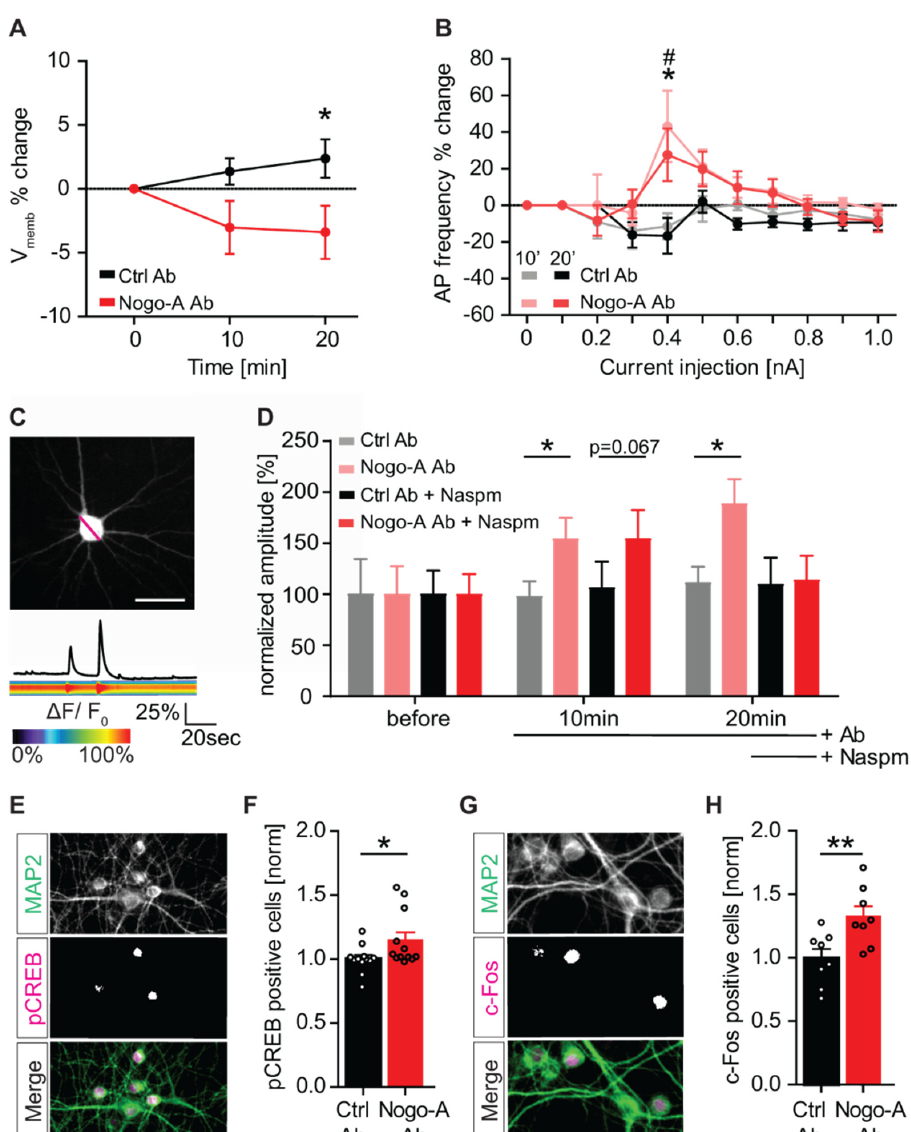
Figure 5. Nogo-A loss-of-function increases neuronal excitability and neuronal activation. ( A , B ) Patch-Clamp electrophysiology recordings of action potential (AP) threshold and frequency upon treatment with either control (black) or Nogo-A function-blocking antibody (red). ( A ) The normalized data show the percentage change of the action potential threshold (V memb ) between both antibody conditions ( n = 11) up to 30 min of treatment. ( B ) The frequency of APs was determined by applying current injections in 0.1 nA steps after 10 min control (grey) and Nogo-A (light red) antibody application, as well as after 20 min (Ctrl-Ab: black, n = 11; Nogo-A Ab: red, n = 10) 10 min: * p , 20min: # p . ( C , D ) Measurement of normalized Ca 2+ transient amplitude percent change in primary hippocampal neurons transfected with GCaMP5g treated either with Nogo-A (red) or control (black) antibody. Antibody treatments were performed for a total time of 40 ( C ) or 20 min with an additional wash in of the CP-AMPAR blocker Naspm after 10 min ( D ). ( E , G ) Immunocytochemical staining for MAP2 (green) and pCREB ( E ) or c-Fos ( G ) (magenta) and their merged image (bottom). For illustration, all images underwent deconvolution and were increased in brightness and contrast for visibility. Scale bar 10 µm. ( F , H ) Normalized data for the number of pCREB ( F ) of c-Fos ( H ) positive neurons, after 10 min treatment with either Nogo-A-blocking (red) or control antibody (black). Each dot represents one coverslip. Data are presented as mean ± SEM. * p < 0.05, ** p < 0.01, # p < 0.05.